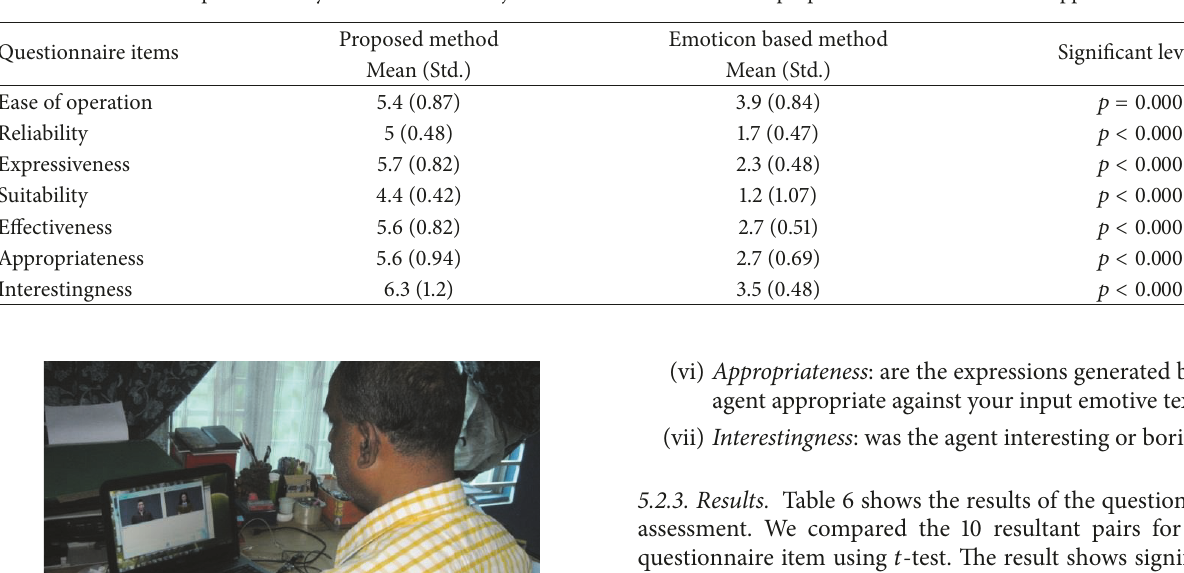
Table 6: Comparative analysis based on the subjective evaluation between the proposed and emoticon based approaches.